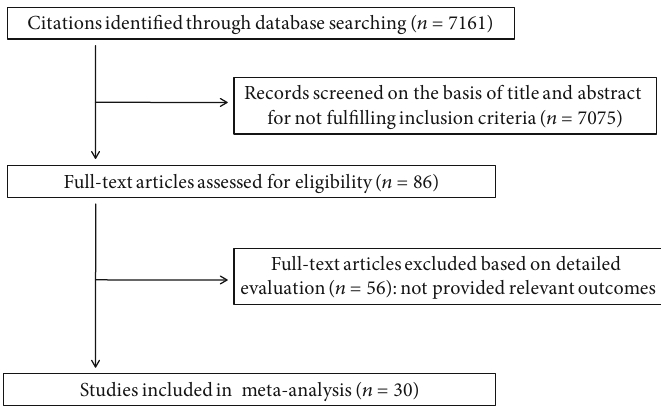
Figure 1: Flow diagram of studies included in